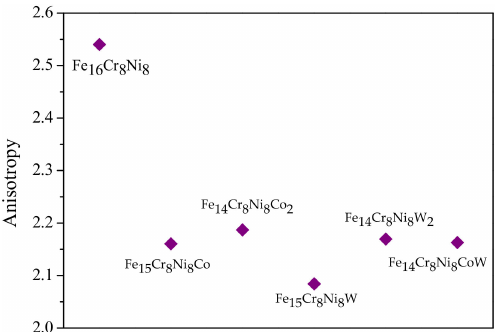
Figure 8. Calculated the Zener’s anisotropy parameter of di ff erent